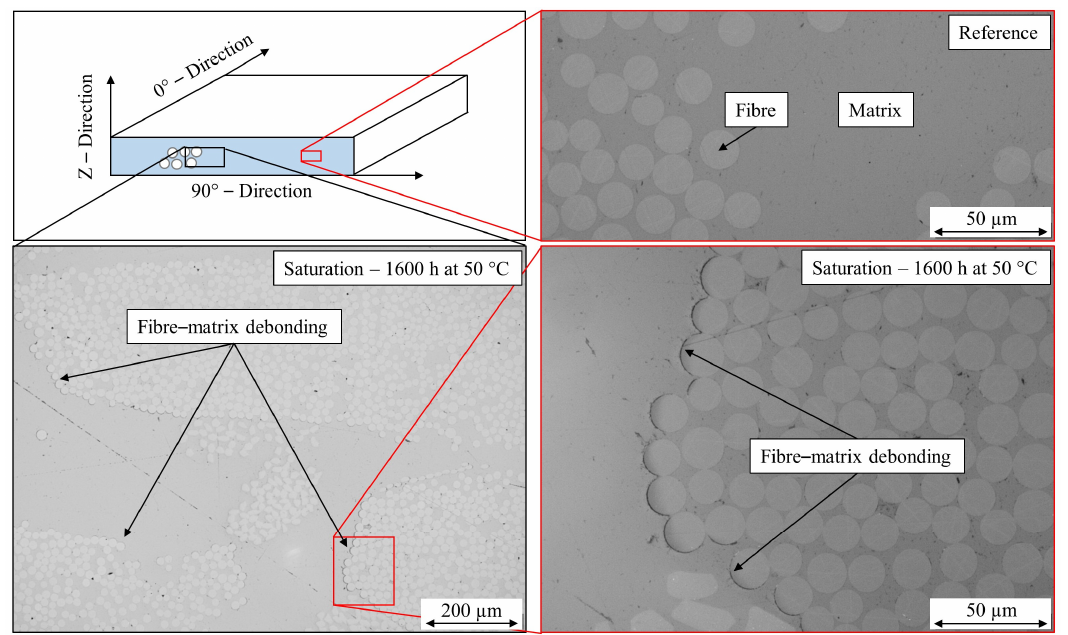
Figure 13. Optical micrographs of laminate cross sections at the initial state (top) and after immersion in salt water at 50 °C for 1600 h (bottom). The long-term immersion leads to extensive fibre–matrix debondings along the outer fibres of a single bundle.